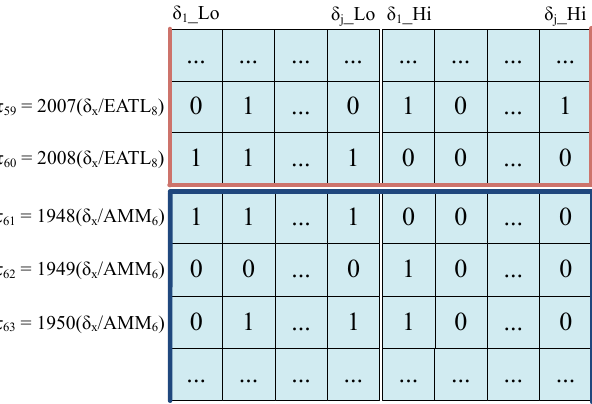
Figure 6. Heterogeneous rule sets are generated for each coupling inciter individually, preserving the independence of their